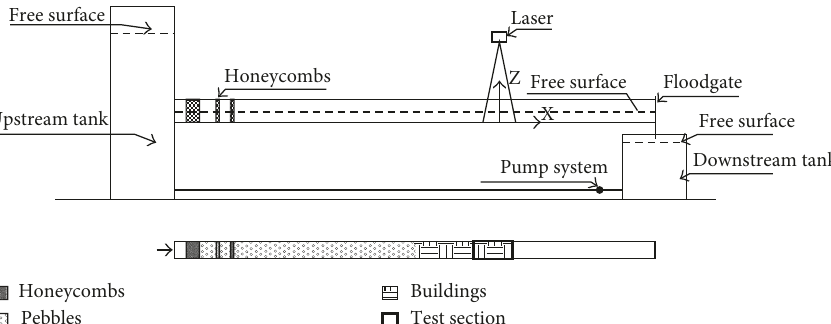
Figure 1: Side and top views of the experimental apparatus. The x -axis refers to the longitudinal axis of the channel (streamwise), while the z -axis is parallel to the